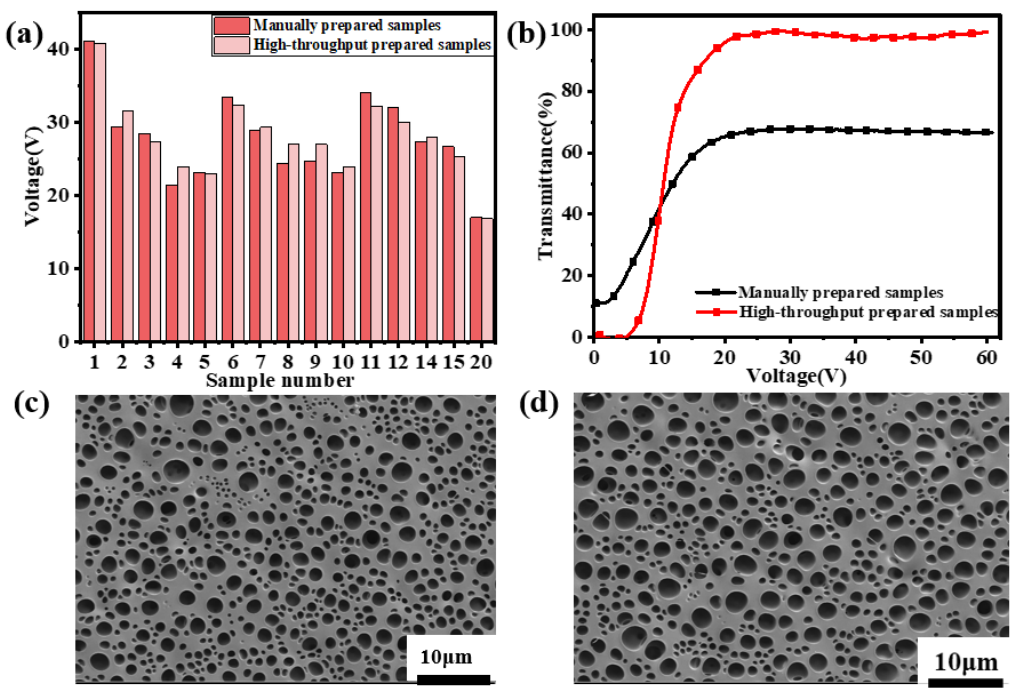
Figure 6. ( a ) Comparison of the saturation voltage of the sample prepared by manual mixing and high-throughput preparation; ( b ) Voltage-transmittance curve of sample No. 20 under manual mixing and high-throughput preparation; ( c ) Micrographography for the preparation of PDLC morphology by high-throughput preparation (sample No. 20); ( d ) Microphotography for manual mixing to prepare PDLC morphology (sample No. 20).